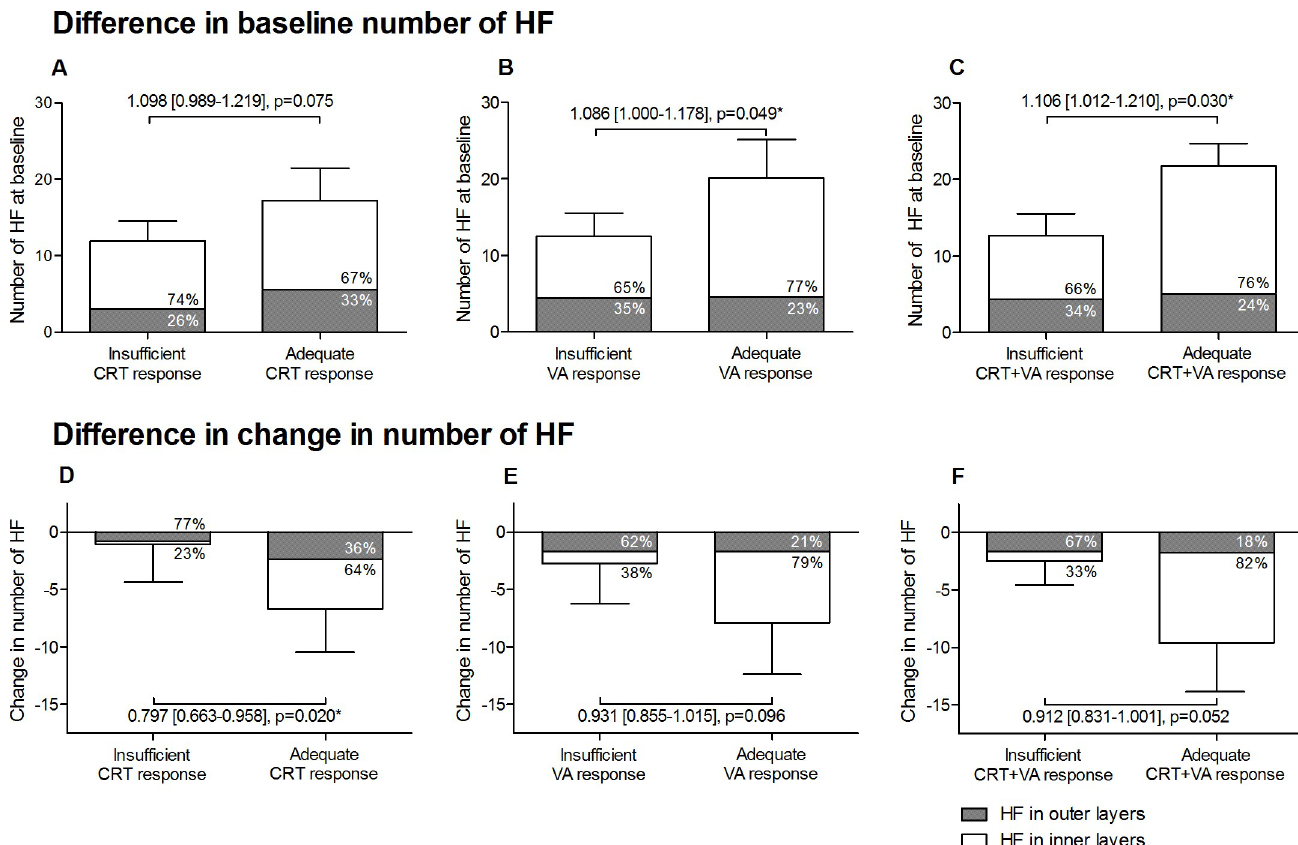
Fig 3. Difference in number of HF at baseline, and change in HF between eyes with adequate response versus insufficient response. Mean number of HF at baseline in groups based on insufficient and adequate CRT response (A); insufficient and adequate VA response (B); and insufficient and adequate combined CRT + VA response (C). Mean change in number of HF in groups based on insufficient and adequate CRT response (D); insufficient and adequate VA response (E); and insufficient and adequate combined CRT + VA response (F). The distribution of HF in the inner and outer retinal layers is displayed as a percentage. The values represent the odds ratio with corresponding 95% confidence interval and p-value. The odds ratio of adequate response is 1.106, which can be interpreted as an increase, or chance, for adequate response by 10.6% for every HF at baseline; when the number of HF at baseline increases by 10, the chance for adequate response increases exponentially by 1.106 10 = 2.74 or 274%. The bars represent mean ± 95% confidence interval and are based on descriptive statistics. � P <